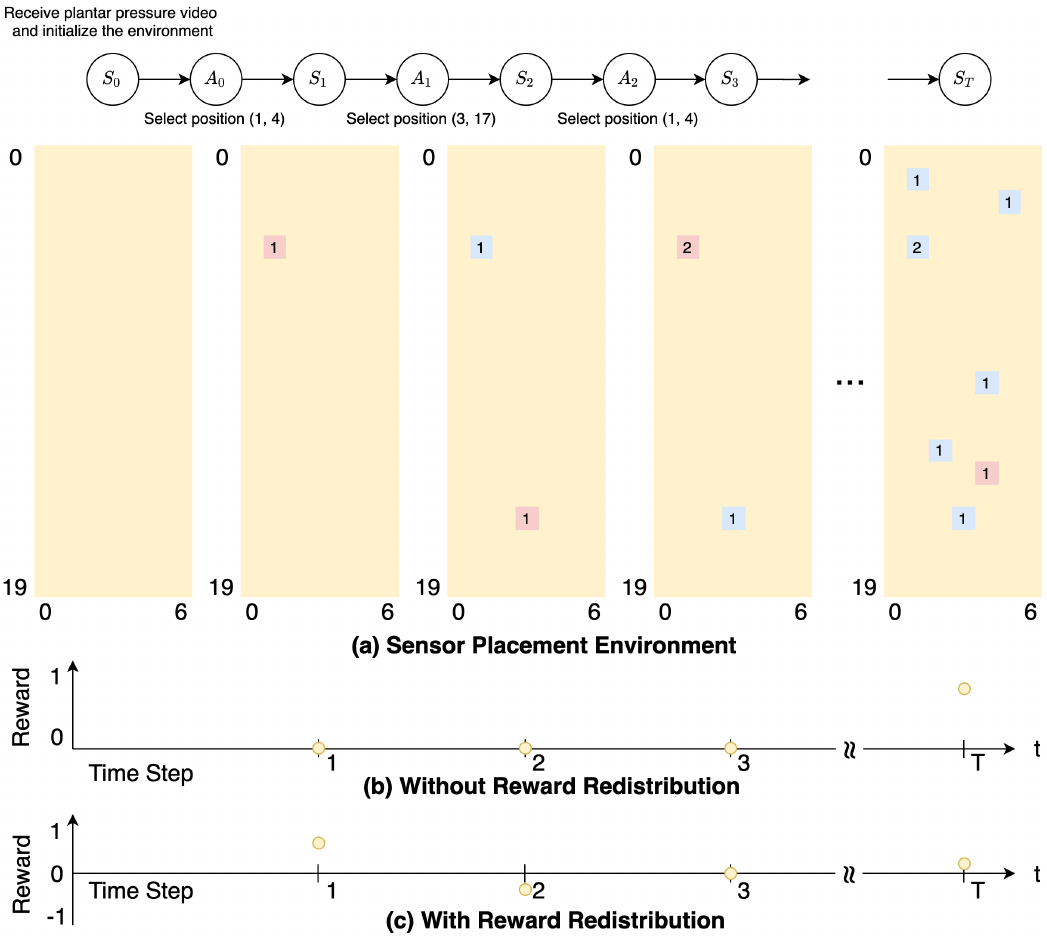
Figure 4. Schematic illustration of the sensor placement environment and reward system. ( a ) The pink point and the blue point represent the agent’s current and previous selecting position separately, and the number represents the sensors count on this position. The notation S T represents the terminate state. S 3 demonstrates the situation when the agent selects a position where another sensor already existed. ( b ) Due to the reward and the next state provided by the environment simultaneously, the first reward starts at S 1 . Without reward redistribution, the agent only receives the reward in the terminate state. ( c ) The redistributed reward is the current and previous accumulative reward difference. Since S 3 has the same masked position as S 2 , they get the same accumulative reward in this episode; the redistributed reward at S 3 is zero. It is also possible to get a negative reward, as shown at S 2